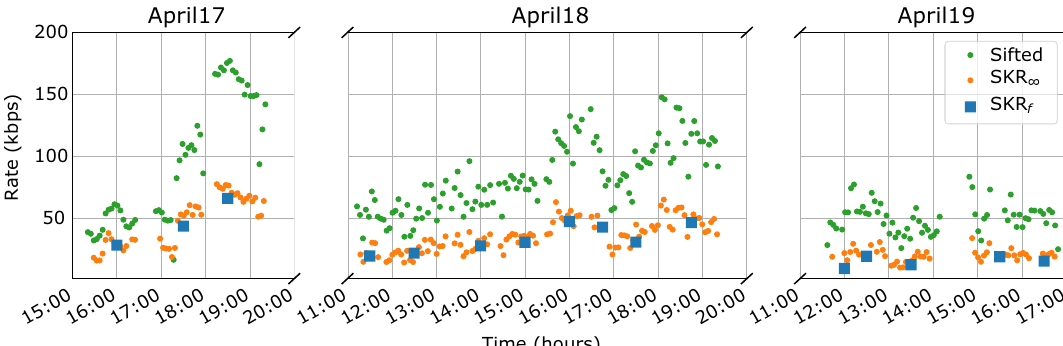
Fig. 3 Results obtained in daylight during three consecutive days of QKD runs. The maximum Sun elevation was about 55 ∘ at 13:00; sunset was around